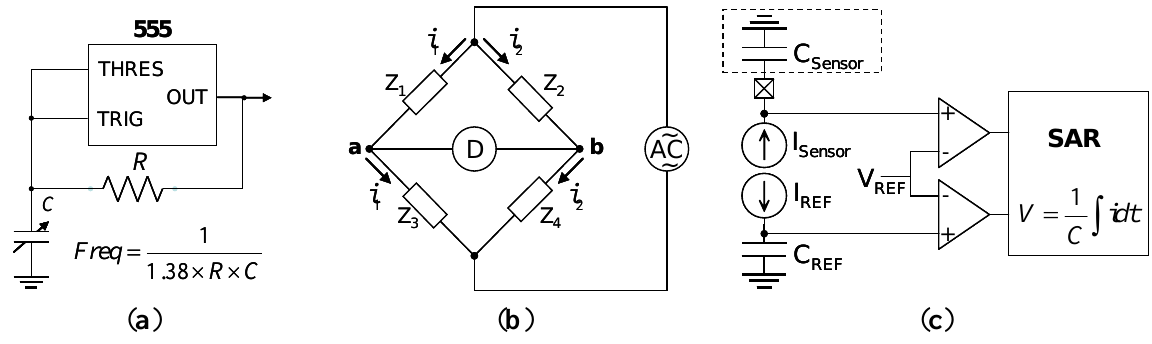
Figure 2. The capacitive-sensing methods: ( a ) the oscillation counting method; ( b ) the AC bridge method; and ( c ) the CT